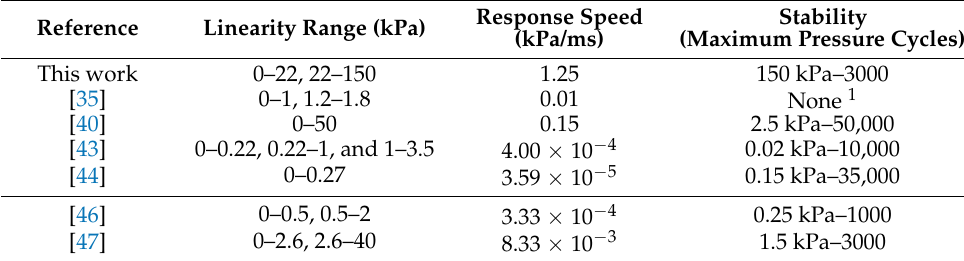
Table 2. Comparison of characteristics with other flexible pressure